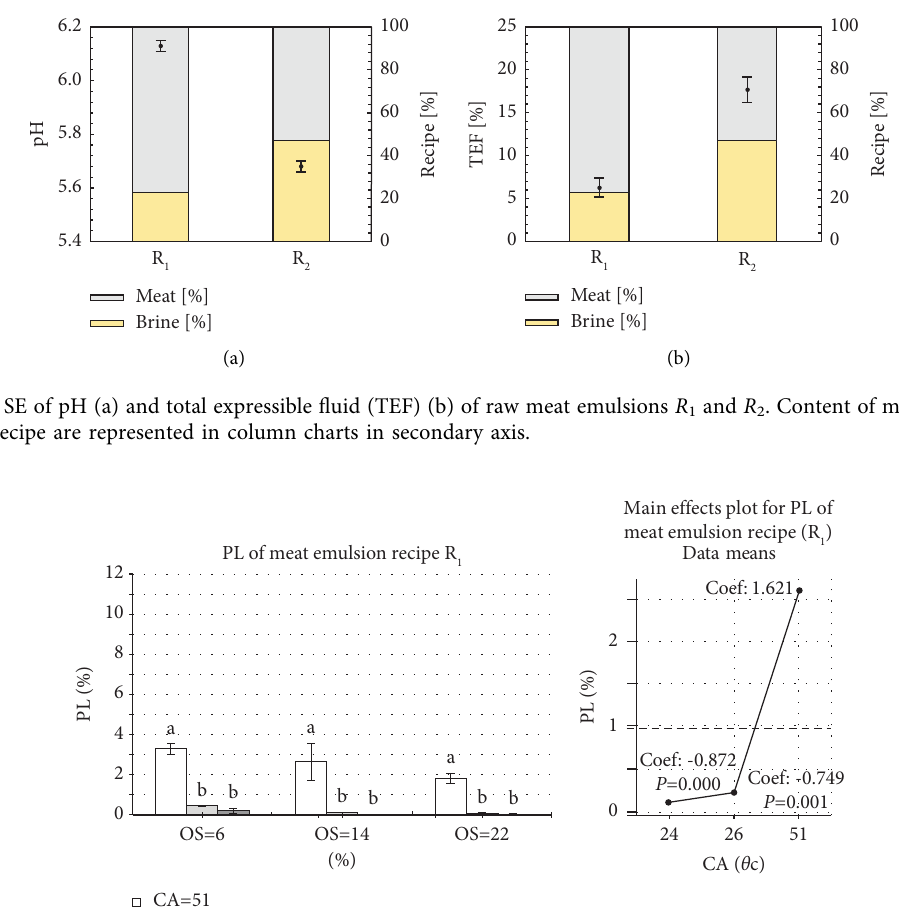
Figure 3: (a) Purge losses (PL) of stufed samples with meat emulsion recipe R1 (TEF: 6.28 ± 1.13%). Diferent lowercase letters indicate a signifcant diference ( P < 0.05) among casings with diferent CA (contact angle). (b) Main efects plot for PL of meat emulsion recipe R 1 . Coefcients and P -valor included in the fgure were taken of the general lineal model analyze (ANOVA). By default, minitab make comparisons with respect of extreme level of each factor (CA: 51 θ c).